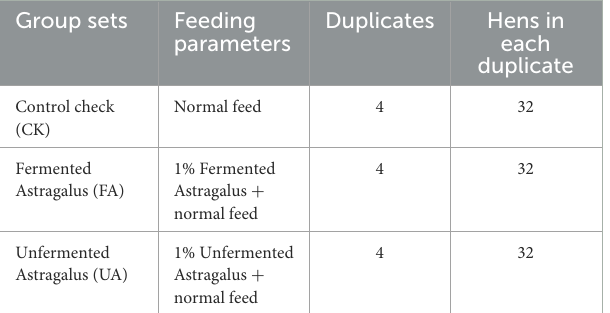
TABLE 1 Parameters of experiment groups for feeding laying